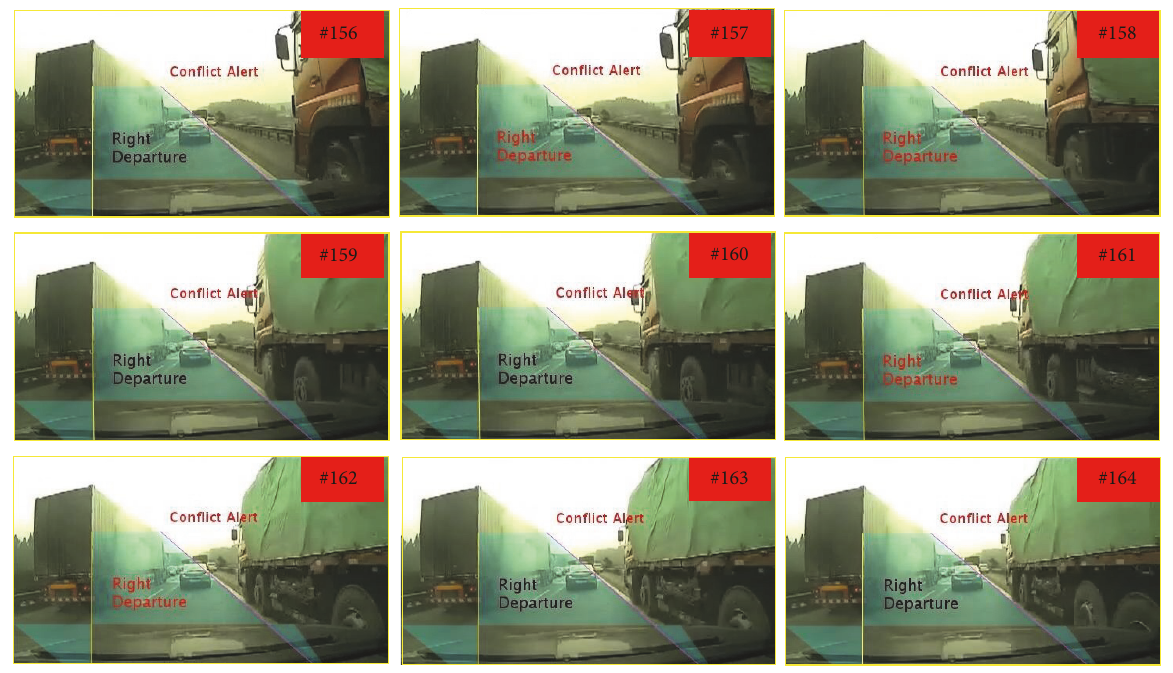
Figure 6: An example does not normally require integration with proposed models; truck exhaust as a regional environmental change has no significant implications to efficiency of the lanes detection and warning of conflict danger. Lanes detection is always working well although a part of detected lane is temporally missing (highlighted by the red caution-texts “Right Departure”) within the period of right departures and a robust and efficient warning of conflict danger (highlighted by the red caution-texts “Conflict Alert”) works well simultaneously during the period (Frame #156 to #164).